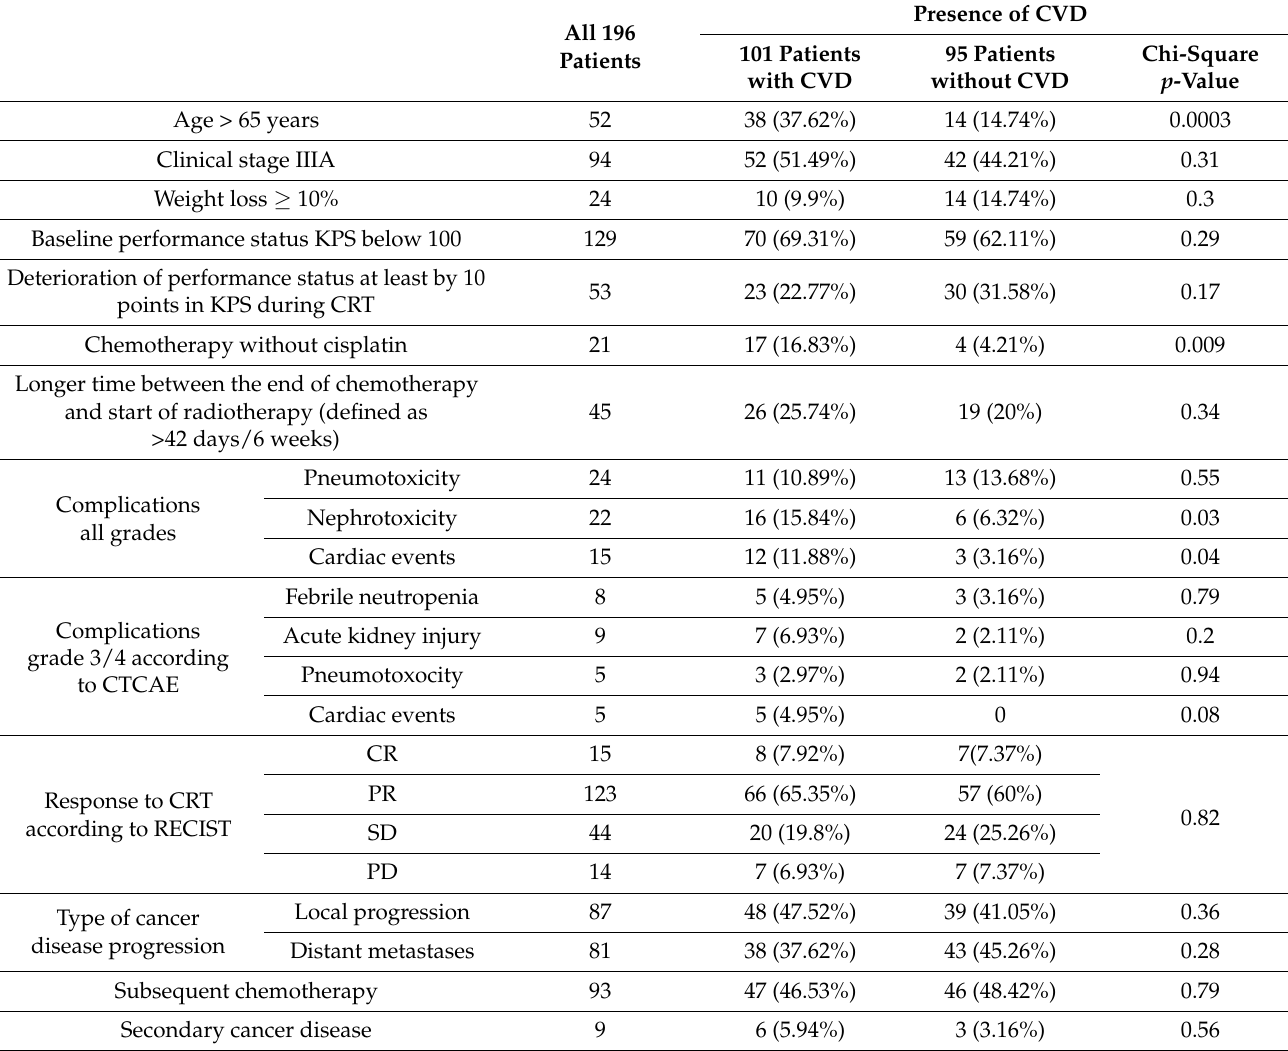
Table 1. The characteristics of patients regarding presence of cardiovascular diseases (CVD).